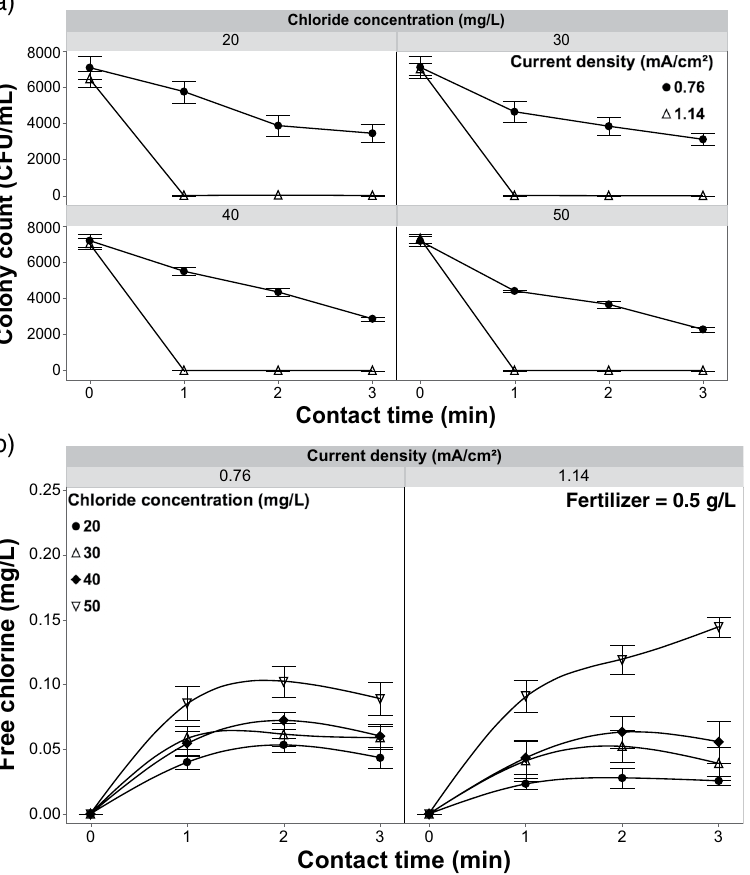
Figure 11. Rhizoctonia solani inactivation and free chlorine dynamics with increasing chloride concentration. ( a ) Inactivation of R. solani as a function of current density with a fertilizer concentration of 0.5 g/L and increasing chloride concentration, and ( b ) effluent free chlorine concentrations observed under the same parameters while increasing the concentration of chloride. Error bars are ± SEM, N = 3.